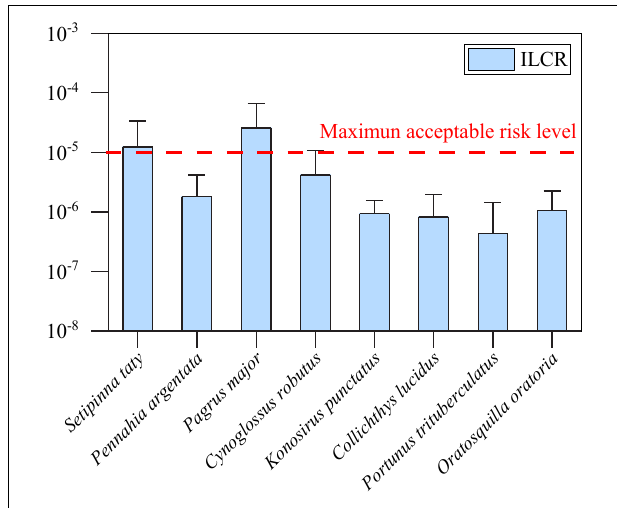
FIGURE 6 | Ranges of the estimated ILCRs by consuming the marine organisms collected from this study